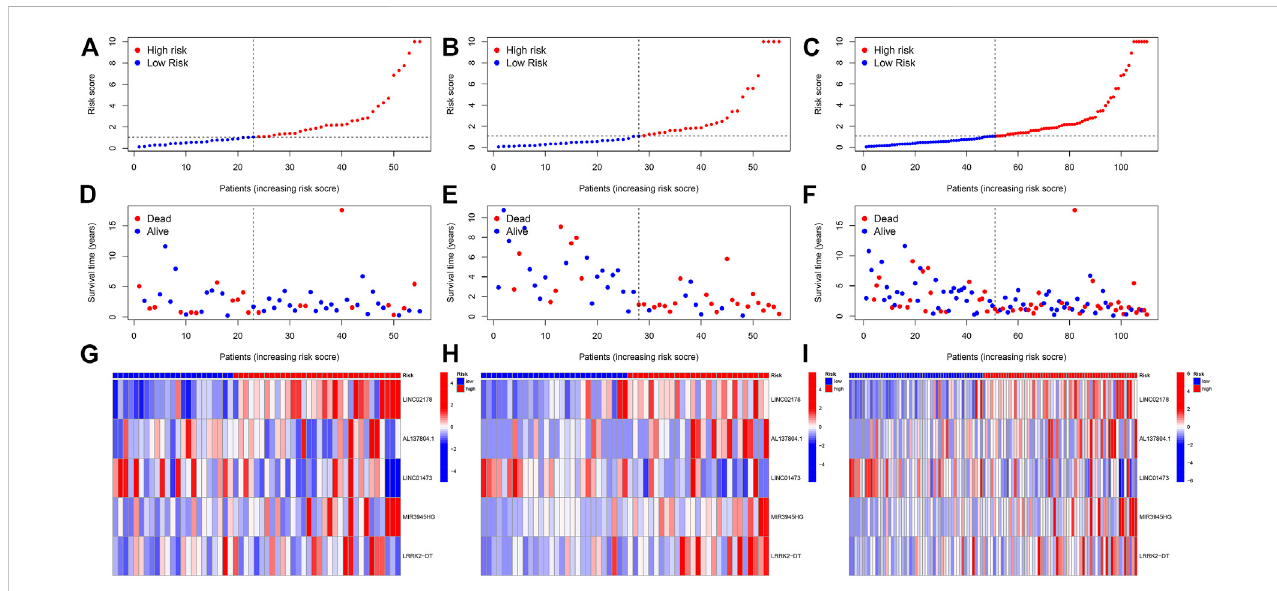
FIGURE 4 (A – C) Classi fi cationofpatients ashighorlowriskbasedonmedianriskscore. (A) isfromthetestingcohort; (B) isfromthetrainingcohortand (C) isfrom theentireset. (D – F) DistributionplotoftheriskscoreandsurvivalstatusofthepatientswithHNSC. (D) isfromthetestingcohort; (E) isfromthetrainingcohort and (F) isfromtheentireset. (G – I) Heatmapofcorrelationbetweenpatientsindifferentriskgroupsandexpressionof5prognosticCRLs. (G) isfromthetesting cohort; (H) is from the training cohort and (I) is from the entire